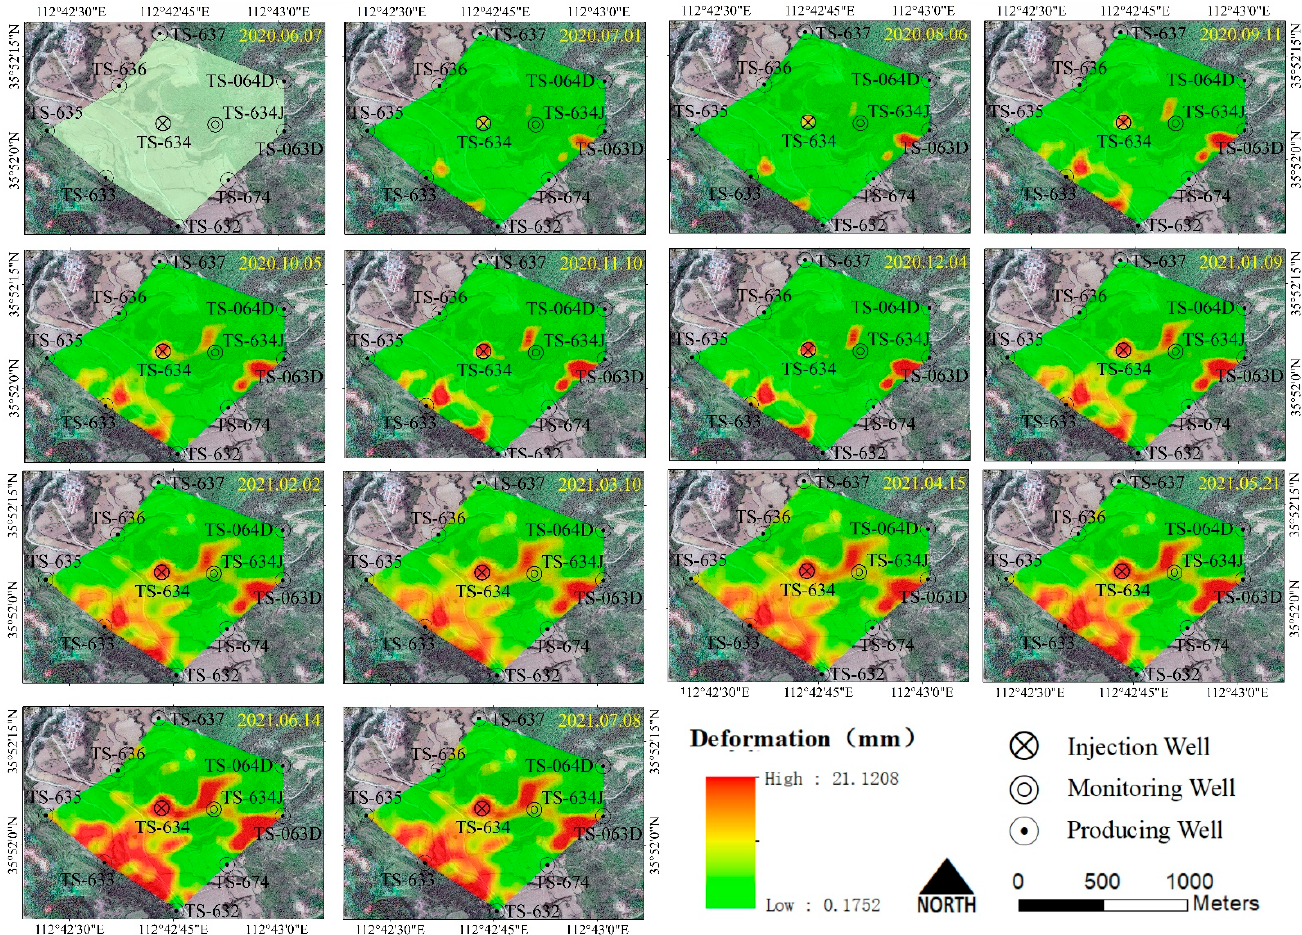
Figure 8. The accumulated surface deformation superimposed on the UAV model of 25 June 2019 for every 24-day interval for about a year after CO 2 was injected.